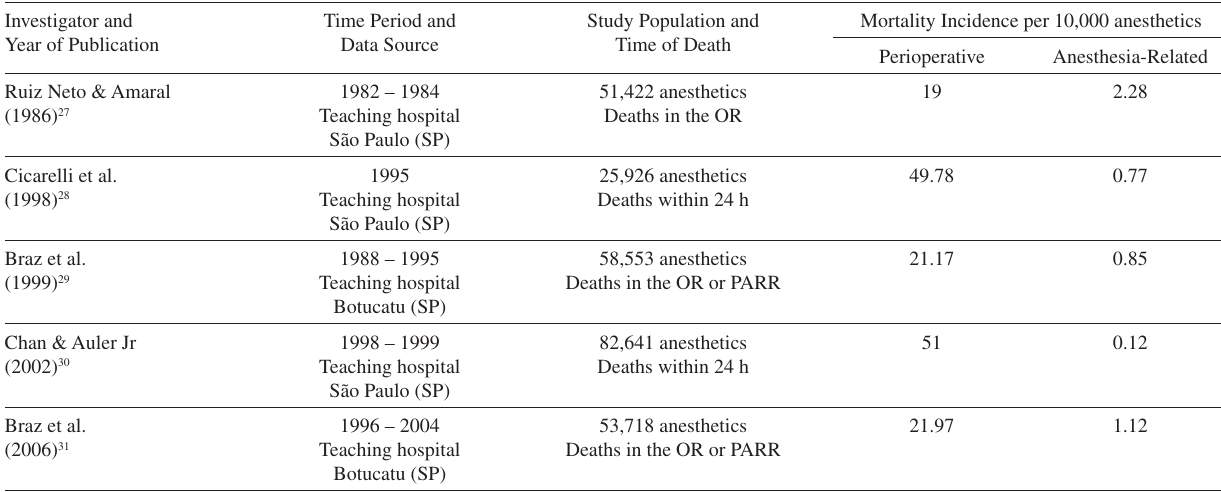
Table 3 - Mortality incidence in patients receiving anesthesia according to Brazilian publications between 1980 and